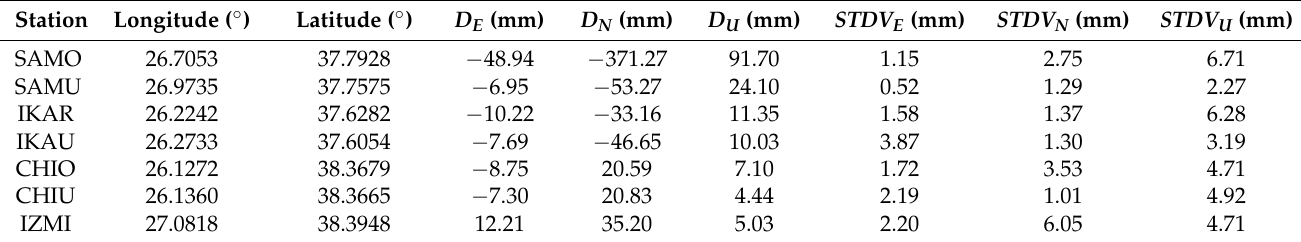
Table 2. Co-Seismic displacements from the GNSS stations (the reference frame is ITRF2014). Notation: D, displacement; STDV, standard deviation; E, east–west; N, north–south; and U, vertical/up.